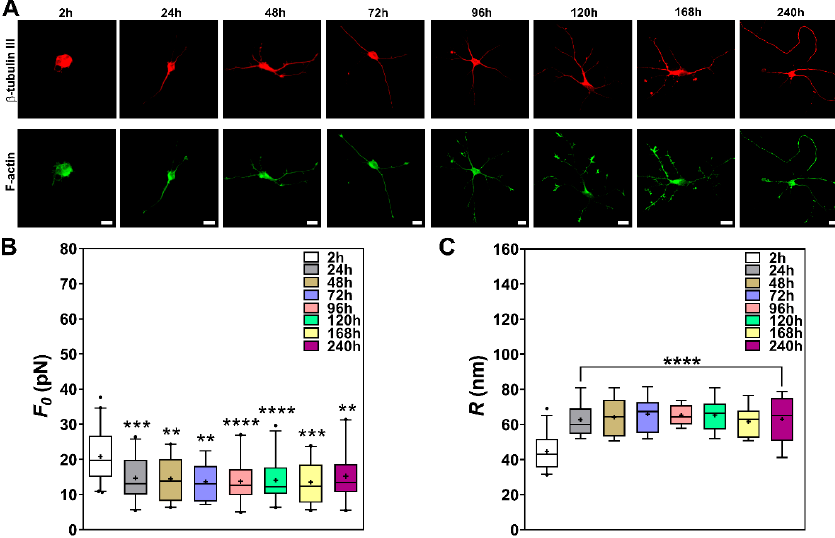
Figure 3. Tether extraction experiments and radius measurements for NPCs cultured in Neurobasal medium. ( A ) Representative images of cells stained for β -tubulin III (red) and F-actin (green) from 2 to 240h. Scale bars are all 10 μ m. ( B–C ) Plot of tether force values (at least 18 different cells) ( B ) and tether radius values (at least 10 different cells) ( C ) for each experimental time point. The colored boxes extend from 25th to 75th percentiles, with a black horizontal line at the median and a black cross at the mean; black whiskers extend from 5th to 95th percentiles; values outside these ranges are plotted as individual points. * means p < 0.05, ** means p < 0.01, *** means p < 0.001, **** means p < 0.0001 in Mann-Whitney U-test statistics when comparing each time point with the 2h condition.